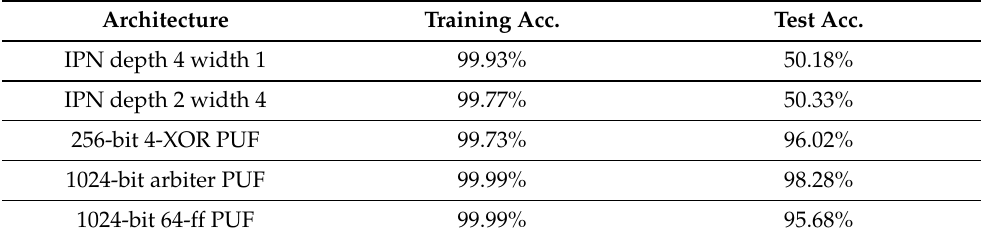
Table 2. Deep neural network attack results.